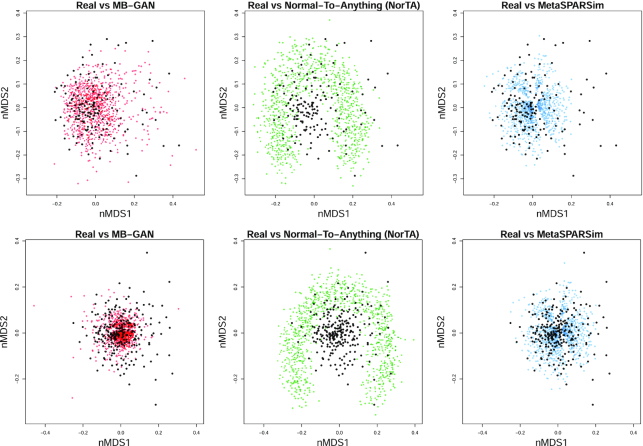
β-diversity visualization using non-metric multidimensional scaling (nMDS) for (a) case and (b) control groups. For samples from the real data, MB-GAN, Normal-To-Anything (NorTA), and metaSPARSim simulated data, the 2D nMDS values were calculated using the unweighted UniFrac metric.